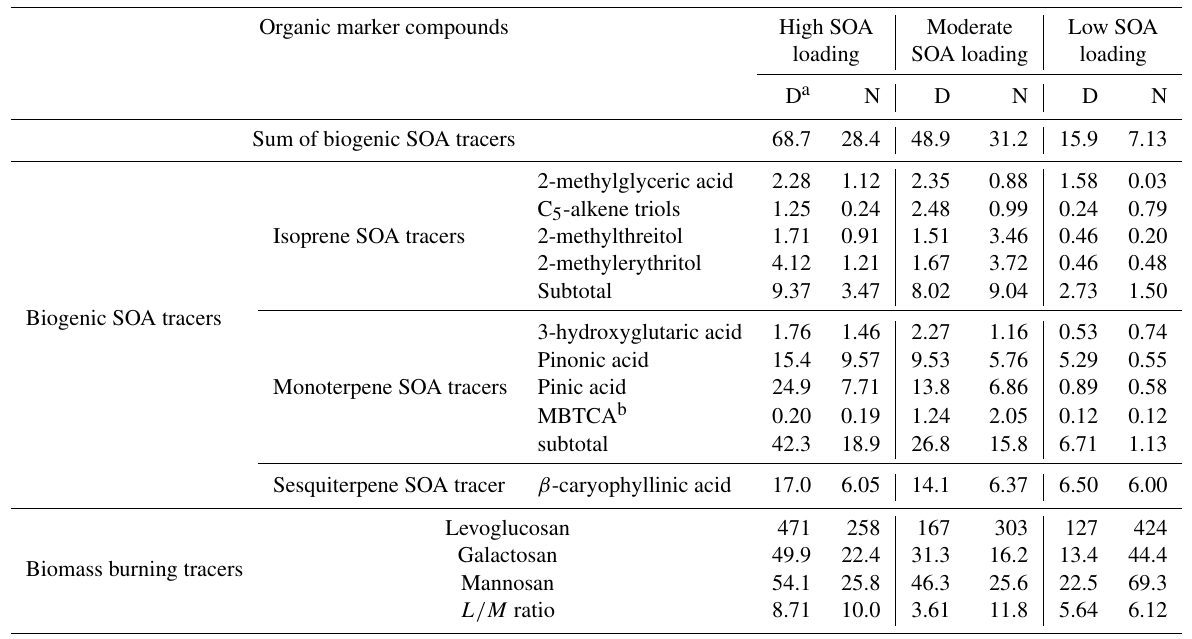
Table 1. The concentrations (ngm − 3 ) of chemical compounds in PM 2 . 5 samples. Organic marker compounds High SOA Moderate Low SOA loading SOA loading loading